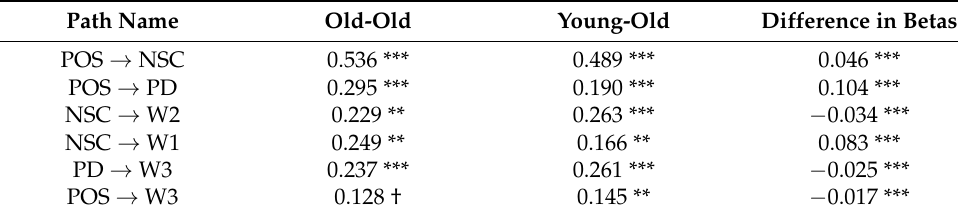
Table 6. Statistical comparison for two age groups. Path Name